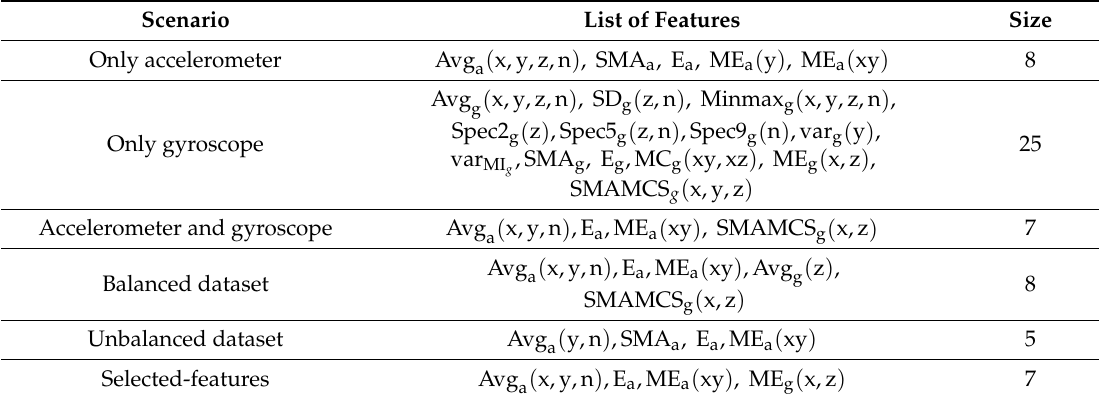
Table 4. The list of essential features for stay activity due to different scenarios.